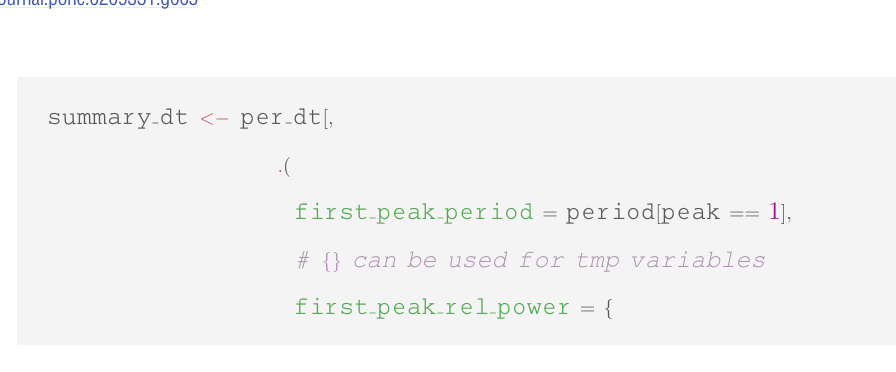
Fig 5. Population statistics on circadian phenotype. A: Average periodograms. The aggregated relative power of the periodogram of all animals. The solid lines and the shaded areas show population means and their 95% bootstrap confidence interval, respectively. B: Frequencies of rhythmic animals. Number of rhythmic animals ( i.e . with a significant peak) in each genotypes. Dark and clear fillings indicate rhythmic and arhythmic animals, respectively. C: Peak periodicity power and average. Values of the peak period for animals with a peak above the significance threshold, at α = 0.05( i.e . rhythmic). Individual animals are shown by dots whose size represent the relative power of the peak period. The error bars are 95% bootstrap confidence interval on the population mean.